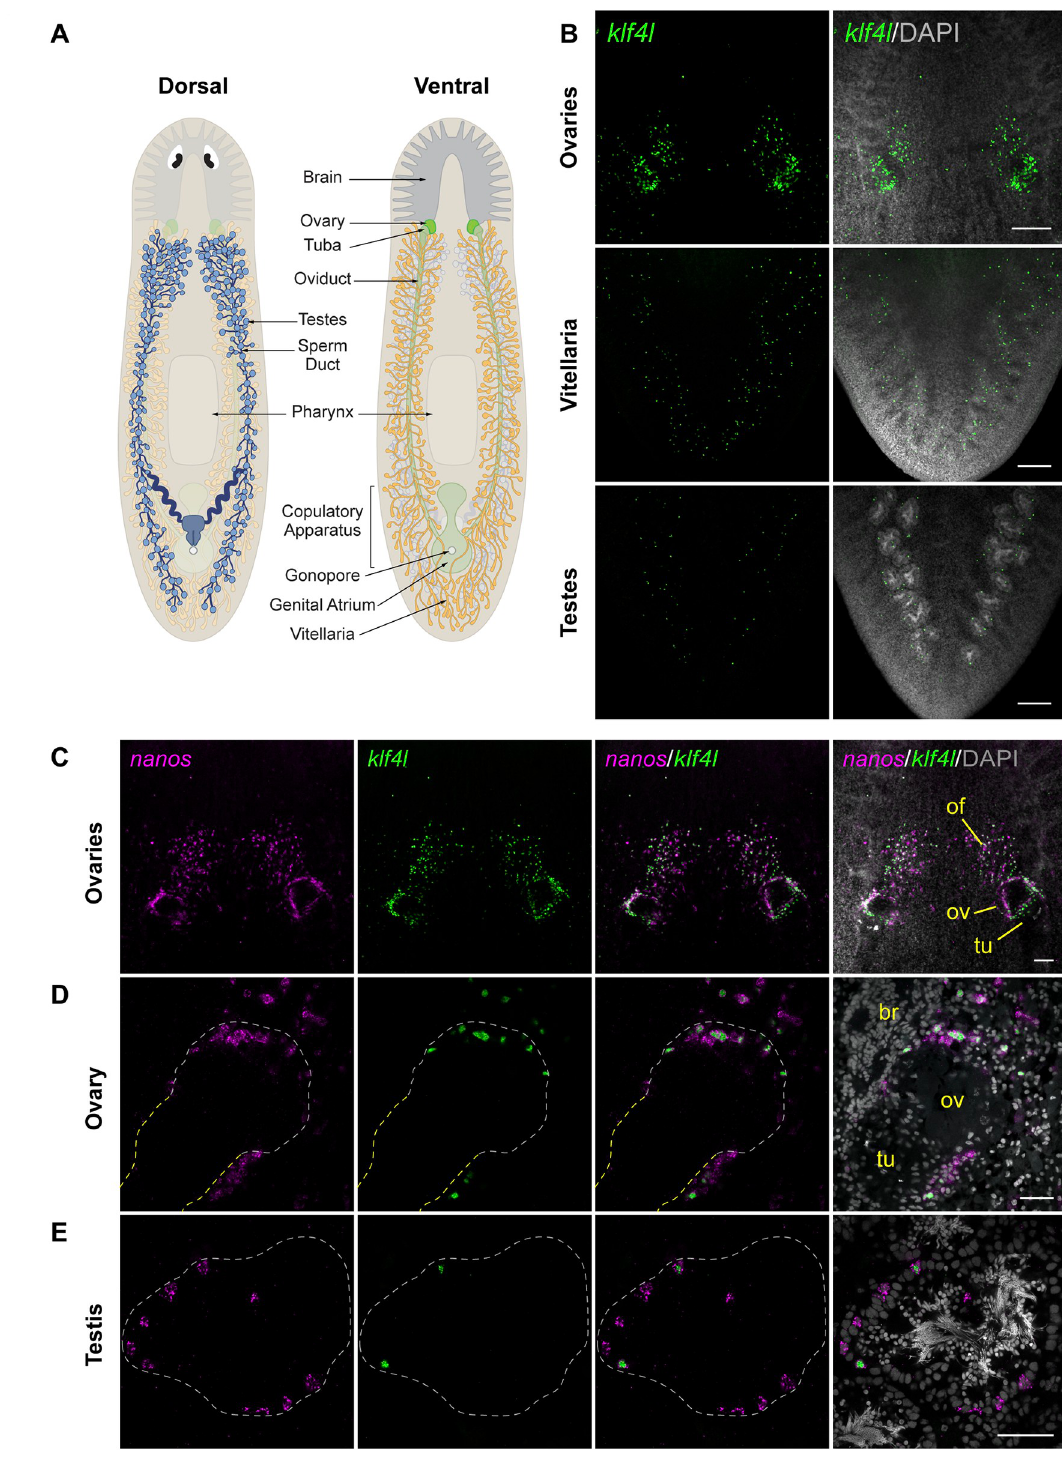
Fig 1. klf4l is expressed in gonads and vitellaria and is restricted to a subset of nanos + germ cells in planarian ovaries and testes. ( A ) Schematics depicting the dorsal (left) and ventral (right) views of landmark structures and various reproductive organs in adult sexual S . mediterranea . ( B ) Maximum intensity projections of confocal sections showing FISH of klf4l (green) in ventral head region (top), ventral tail region (middle), and dorsal tail region (bottom). ( C ) Maximum intensity projection of confocal sections showing dFISH of klf4l (green) and germline marker nanos (magenta) in ventral head region. klf4l- and nanos -expressing cells are detected